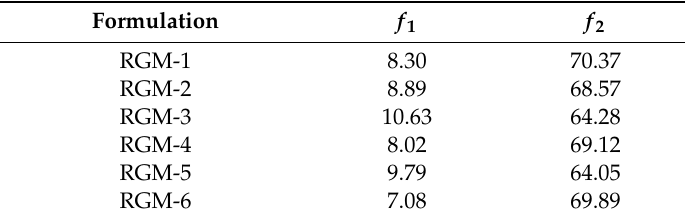
Table 3. Di ff erence factor ( f 1 ) and the similarity factor ( f 2 ) values between the paddle method and the modified basket method.